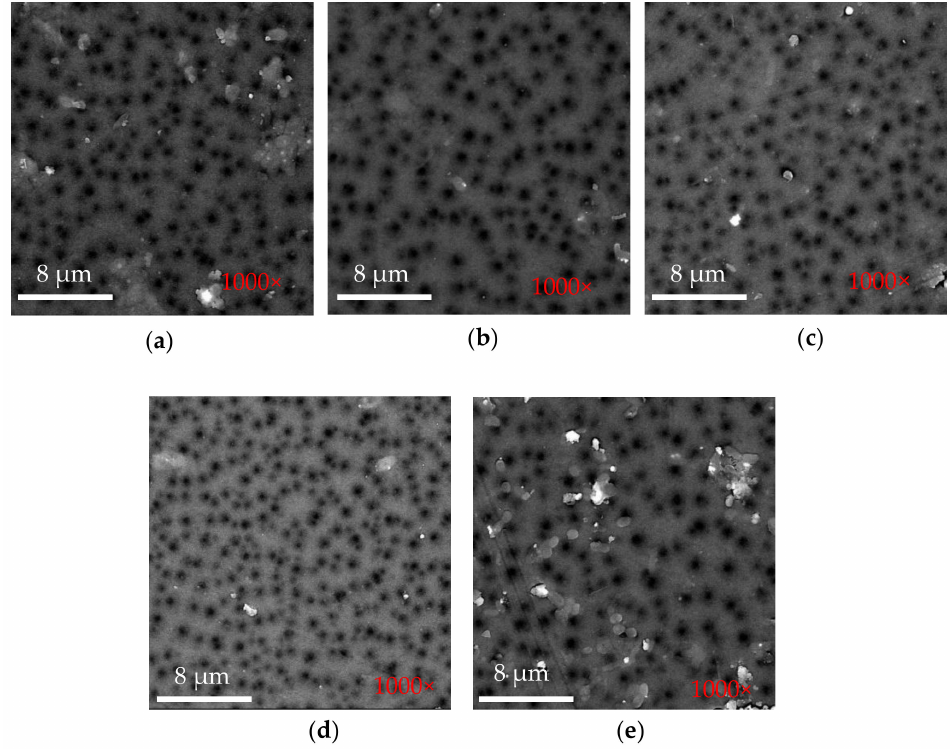
Figure 9. Surface SEM micrographs of ( a ) bare PSF ( b ) PSF-SNF 0.1 wt.%, ( c ) PSF-SNF 0.2 wt.%, ( d ) PSF-SNF 0.3 wt.% and ( e ) PSF-SNF 0.4 wt.%